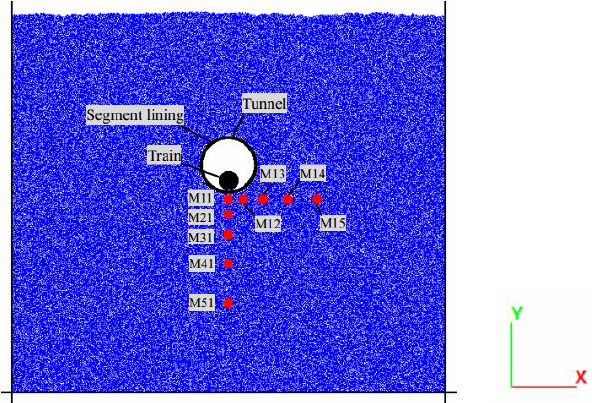
Figure 1. Section model of the metro